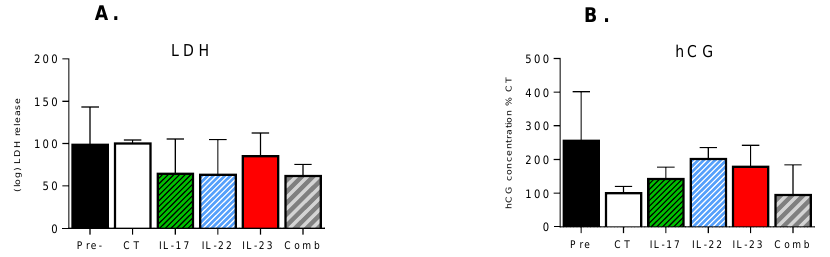
Figure 4. Effect of cytokine treatments on the viability of cultured placental explants, as measured by ( A ) Lactate Dehydrogenase (LDH) release and ( B ) human chorionic gonadotropin (hCG) secretion, over the 24 h treatment period. LDH and hCG were measured in the culture media collected from 6–8 explants and 3–4 explants, respectively. Pretreatment (Pre) levels are shown. Data are normalized to the untreated controls (CT) and are presented as mean ± SEM. No significant differences were detected.